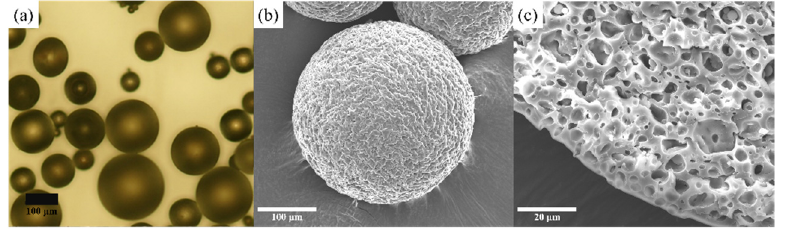
Figure 3. Optical images of P-M 1 . 5 A 1400 T 0 . 6 -2L ( a ) and cross-sectional SEM images of P-M 1 . 5 A 1400 T 0 . 6 -2L ( b ) ×1000 and ( c ) ×5000.